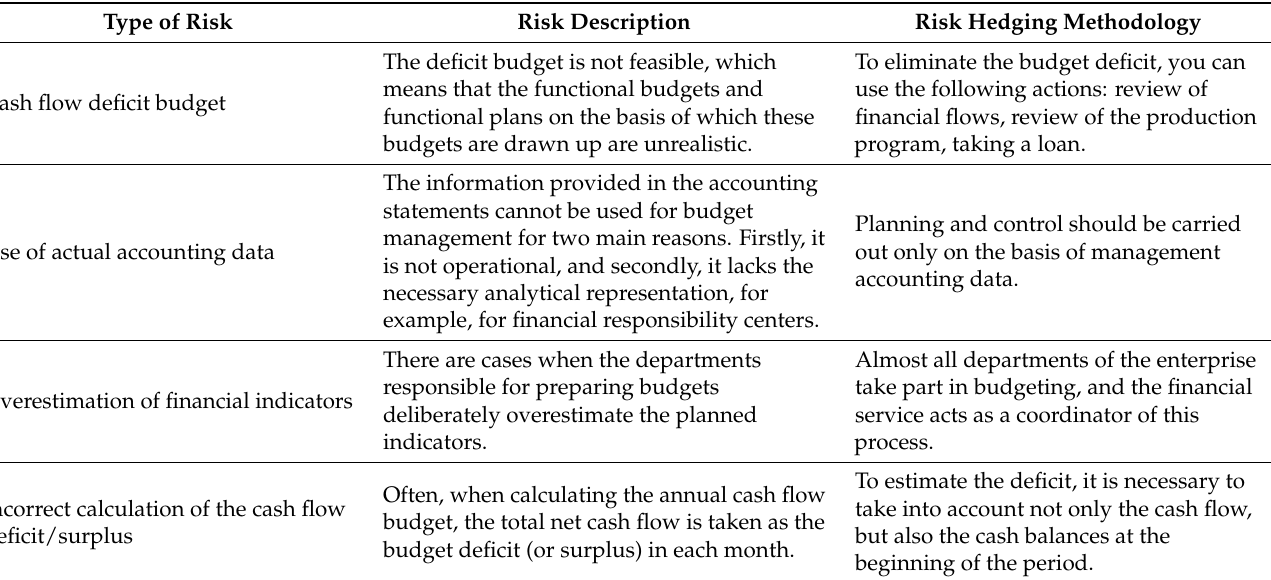
Table 3. Types of risks that correspond to the situation of applying the new methodology for assessing financial capacity. Type of Risk Risk Description Risk Hedging Methodology